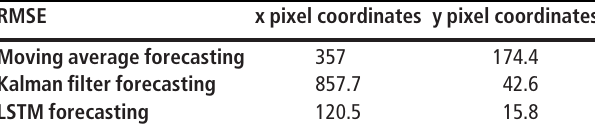
Table 3 RMSE of trajectory prediction